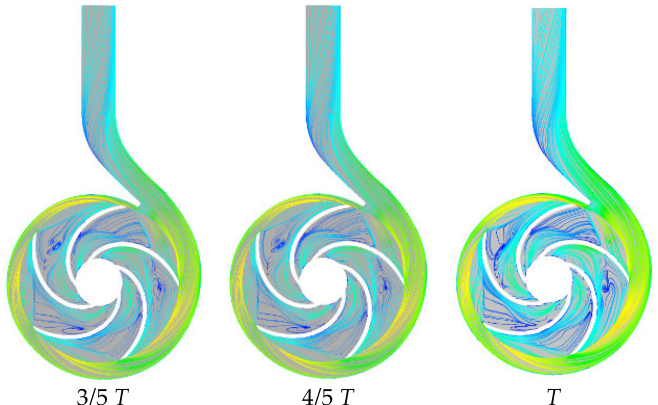
Figure 10. Velocity streamline distribution under gas–liquid two-phase in one complete cycle.